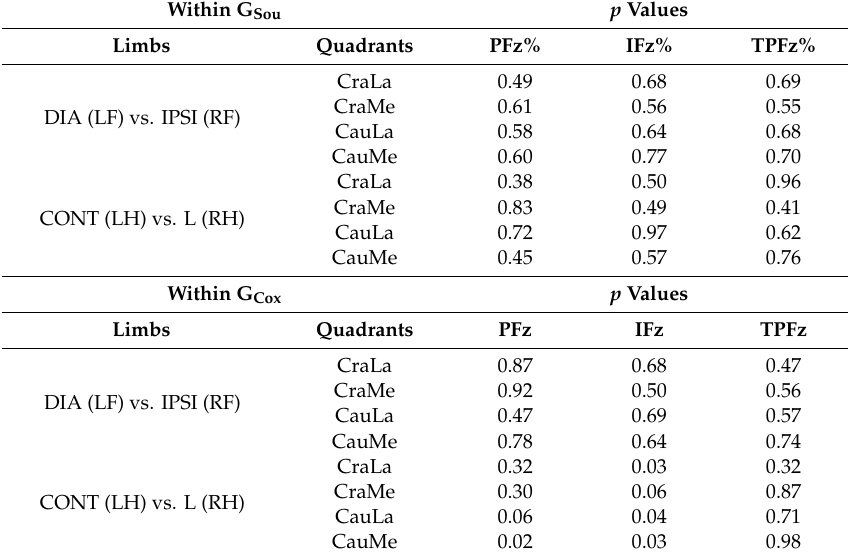
vs.: versus. Level of significance at p < 0.05. PFz% (peak of vertical force normalized as percentual of total force); IFz% (vertical impulse normalized as percentual of total force); SPD (s) (stand phase duration in seconds); TPFz% (time of occurrence of peak of vertical force as a percent of the stance phase duration); LF (left front limb); RF (right front limb); LH (left hind limb); RH (right hind limb); DIA (diagonal limb); IPSI (ipsilateral limb); CONT (contralateral limb); L (lame limb); CraLa (craniolateral); CraMe (craniomedial); CauLa (caudolateral); CauMe (caudomedial). Animals 2020 , 10 , x